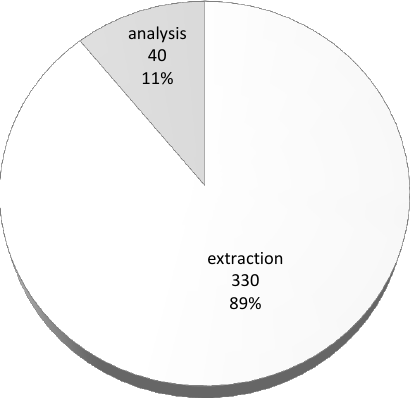
Figure 10. Computational costs of data extraction and data analysis for the sample U-SQL script executed for proteins from the data set DS2 stored in ten sequential files with 10